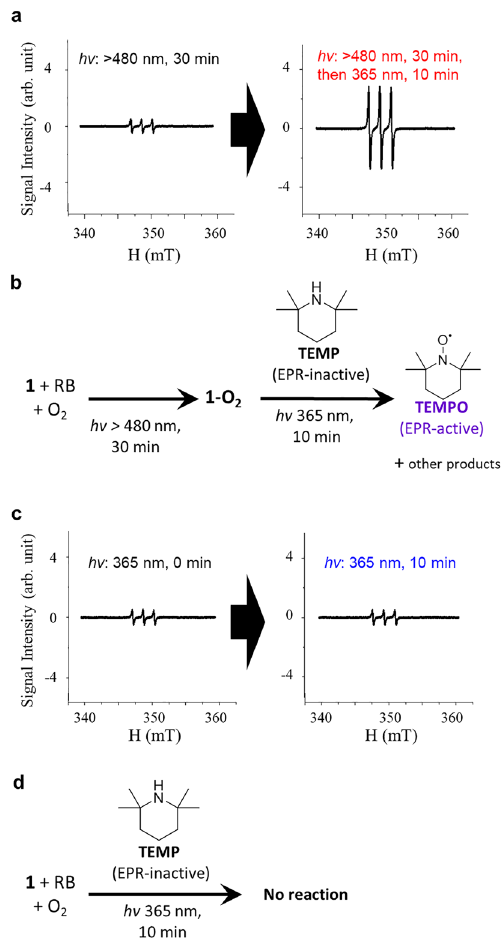
Figure 4. EPR measurements on the sample solution of 1 and RB. (a ) EPR spectra of the sample solution of 1 and RB (2:1, mol/mol) recorded under the illumination by a xenon lamp (long-pass filter for 480 nm, 30 min, 50 mW), and then TEMP was added. The spectra were recorded: (left) before and (right) after the UV illumination (365 nm, 10 min, 2 mW cm −2 ). The triplet signal seen in the left figure corresponds to the residual signal from TEMPO in the TEMP. ( b ) The corresponding reaction scheme for ( a ). ( c ) EPR spectra of the control experiment only with the UV illumination of a solution of 1 , RB, and TEMP (2:1:1000, mol:mol:mol): (left) before and (right) after the UV illumination (365 nm, 10 min, 2 mW cm −2 ). ( d ) The corresponding reaction scheme for ( c